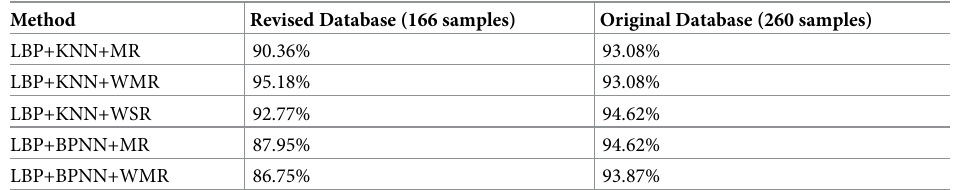
Table 7. Comparison of classification results with two databases.